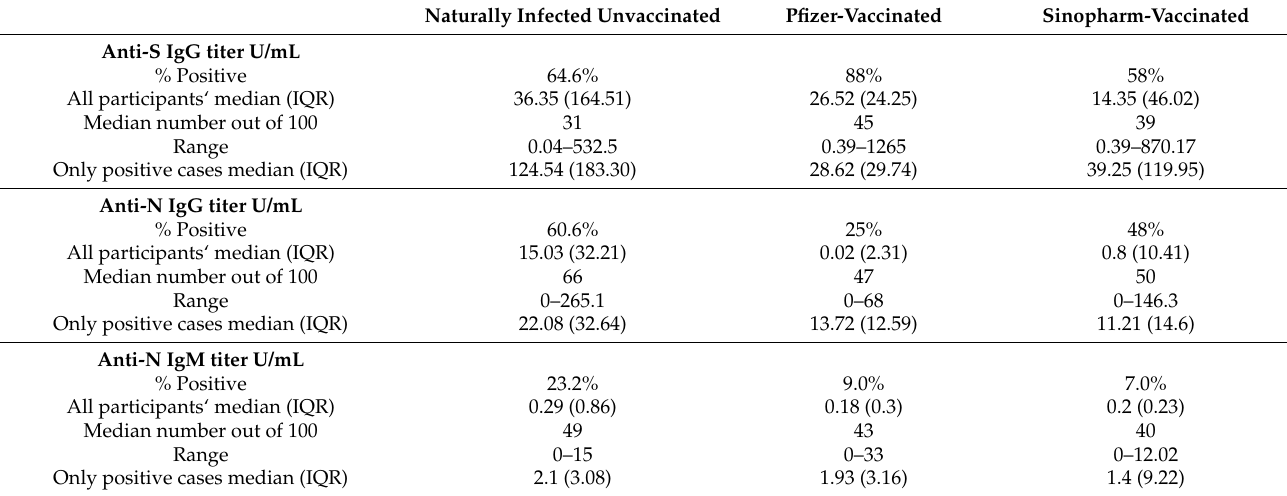
Table 2. Comparing anti-S and anti-N levels in naturally infected unvaccinated and vaccinated subjects. Naturally Infected